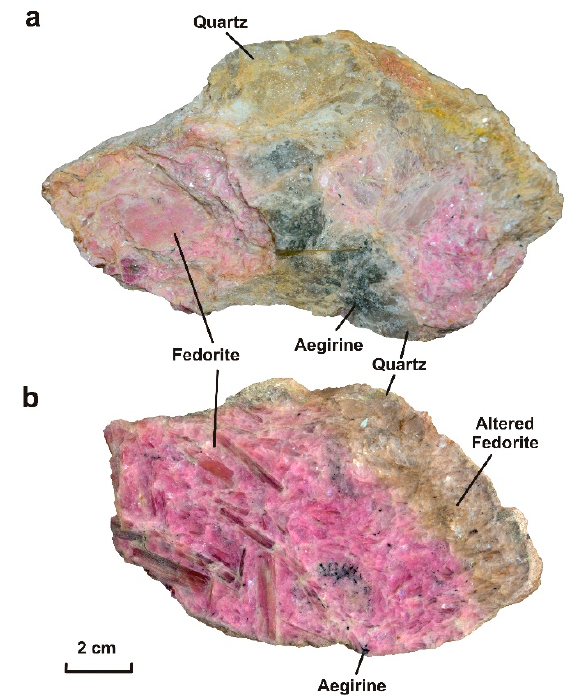
Figure 1. Sample Gav-43 with fedorite from the Gavrilovskaya zone: ( a ) unpolished sample, ( b ) polished sample.